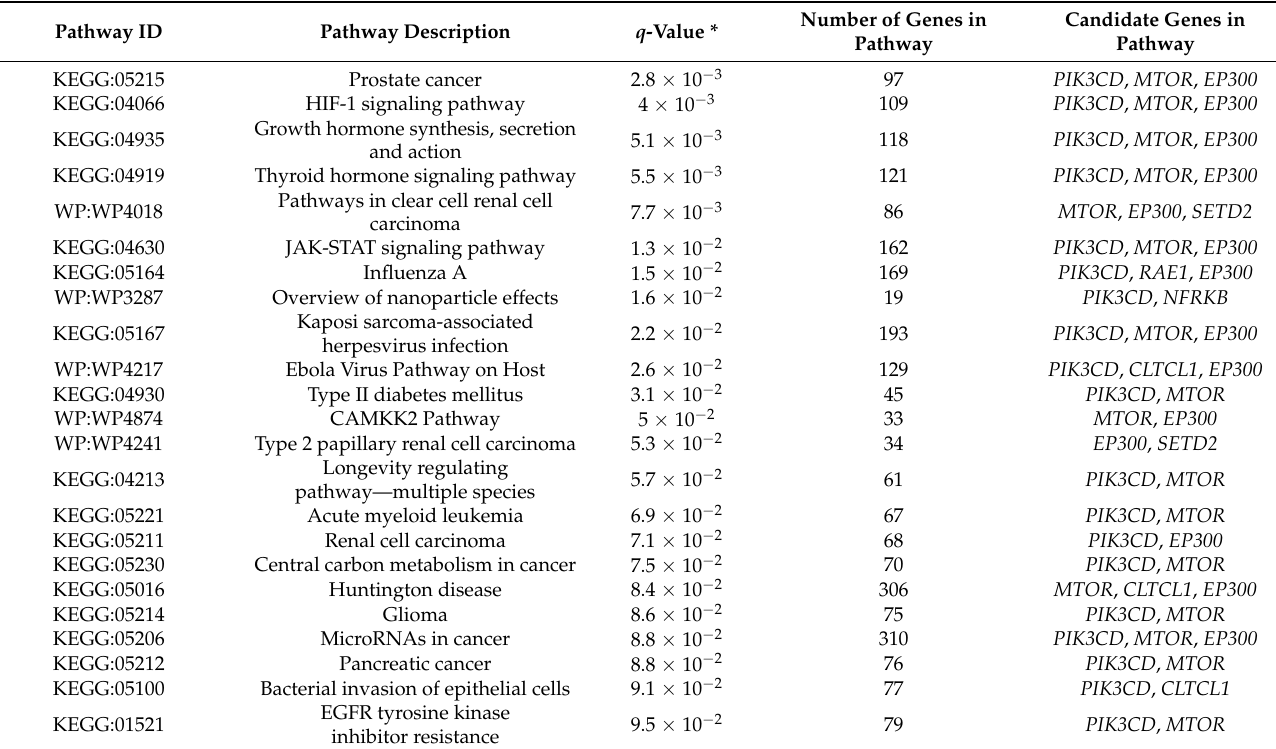
Table 5. Biological pathways associated with the 13 candidate susceptibility genes identified in 46 French cases diagnosed with both CMM and